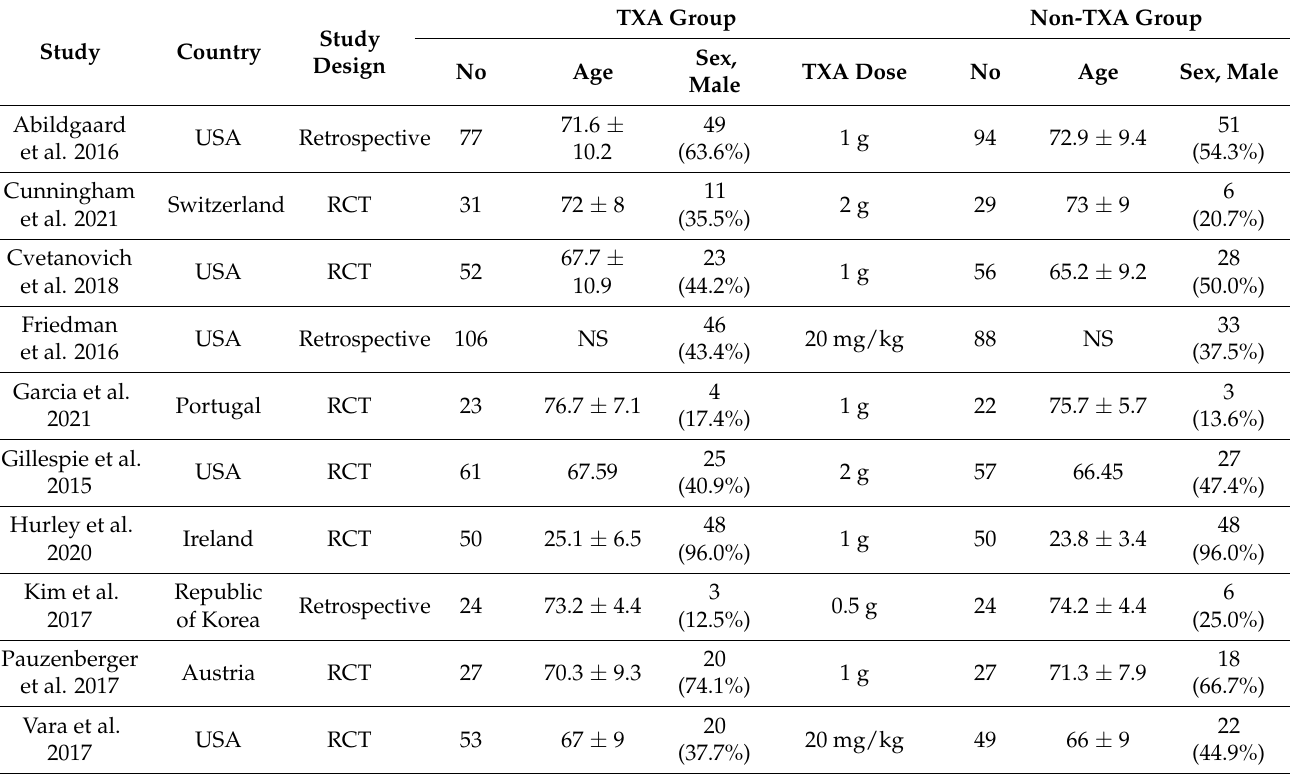
Table 1. Study characteristics.